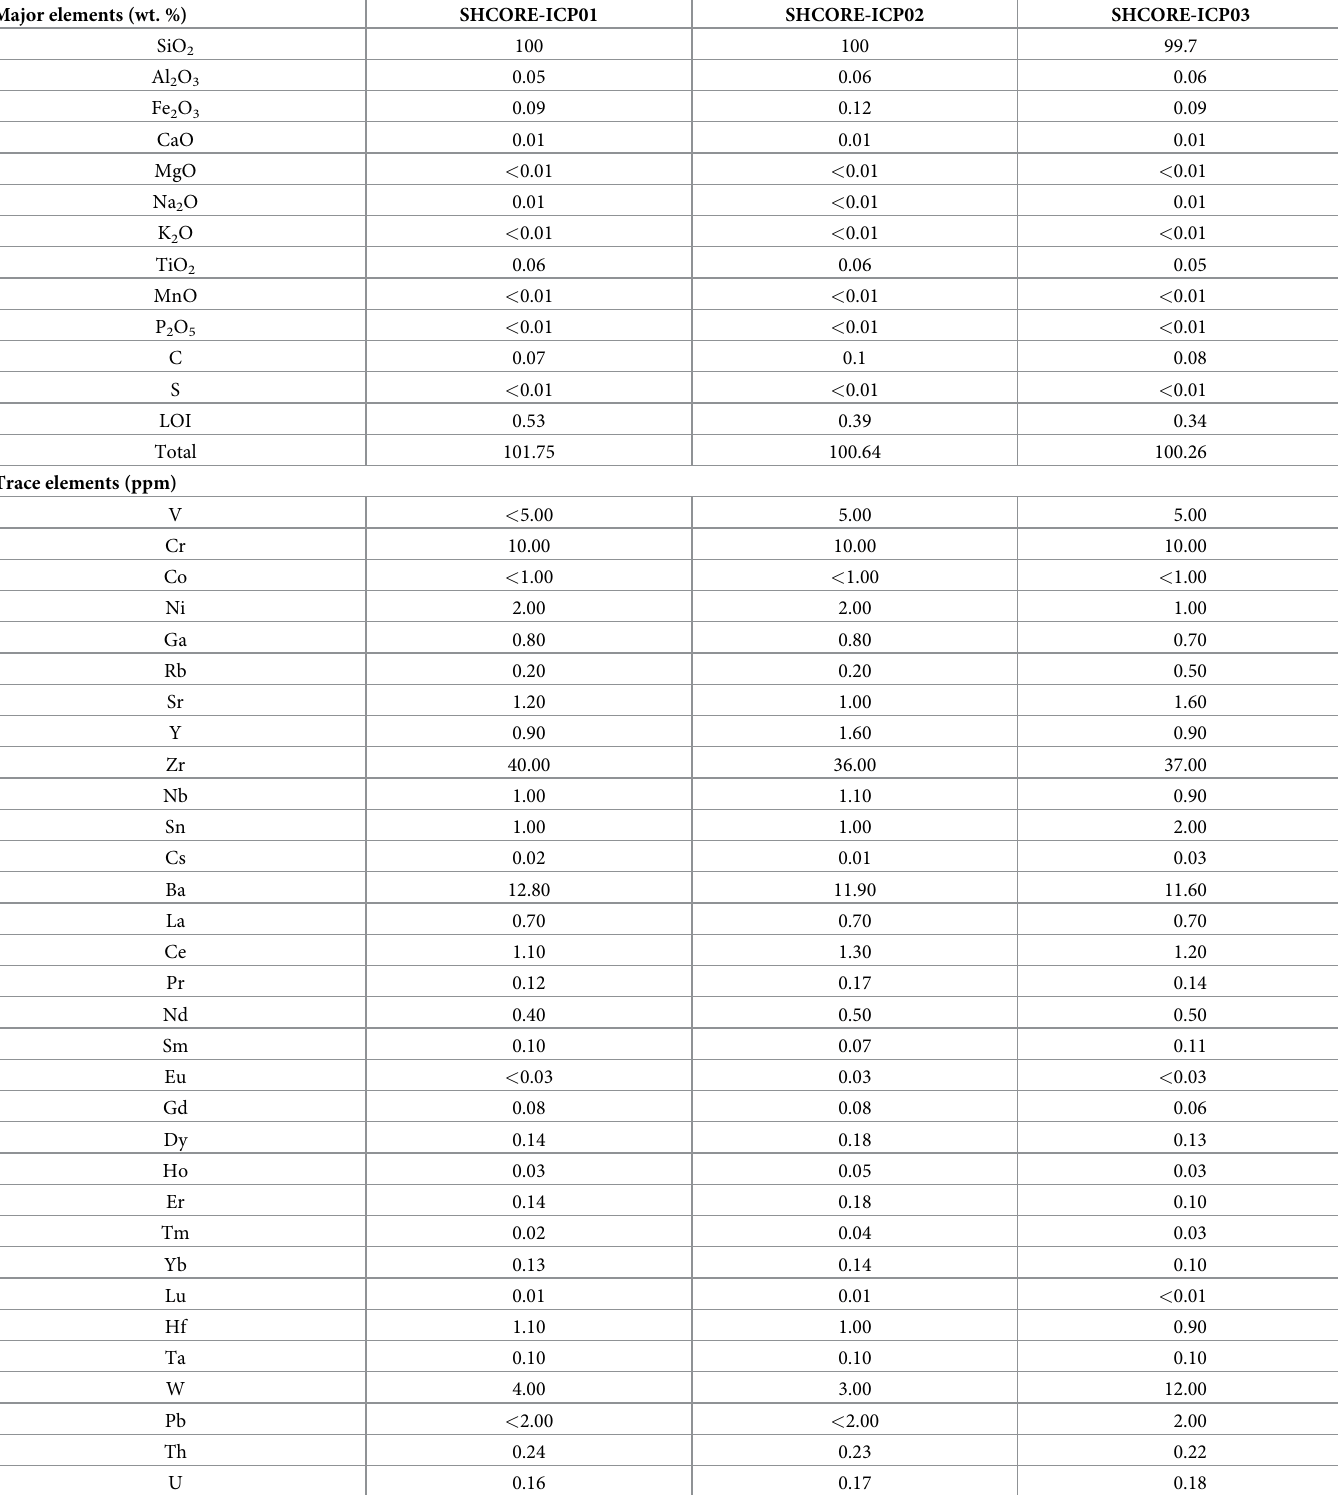
Table 5. Whole-rock major and trace element geochemical data (by ICP-AES and ICP-MS) for three subsamples from section 2–3 of the Phillips’ Core (Stone 58, Stonehenge). Detection limit is indicated by inequality sign. Major elements (wt.